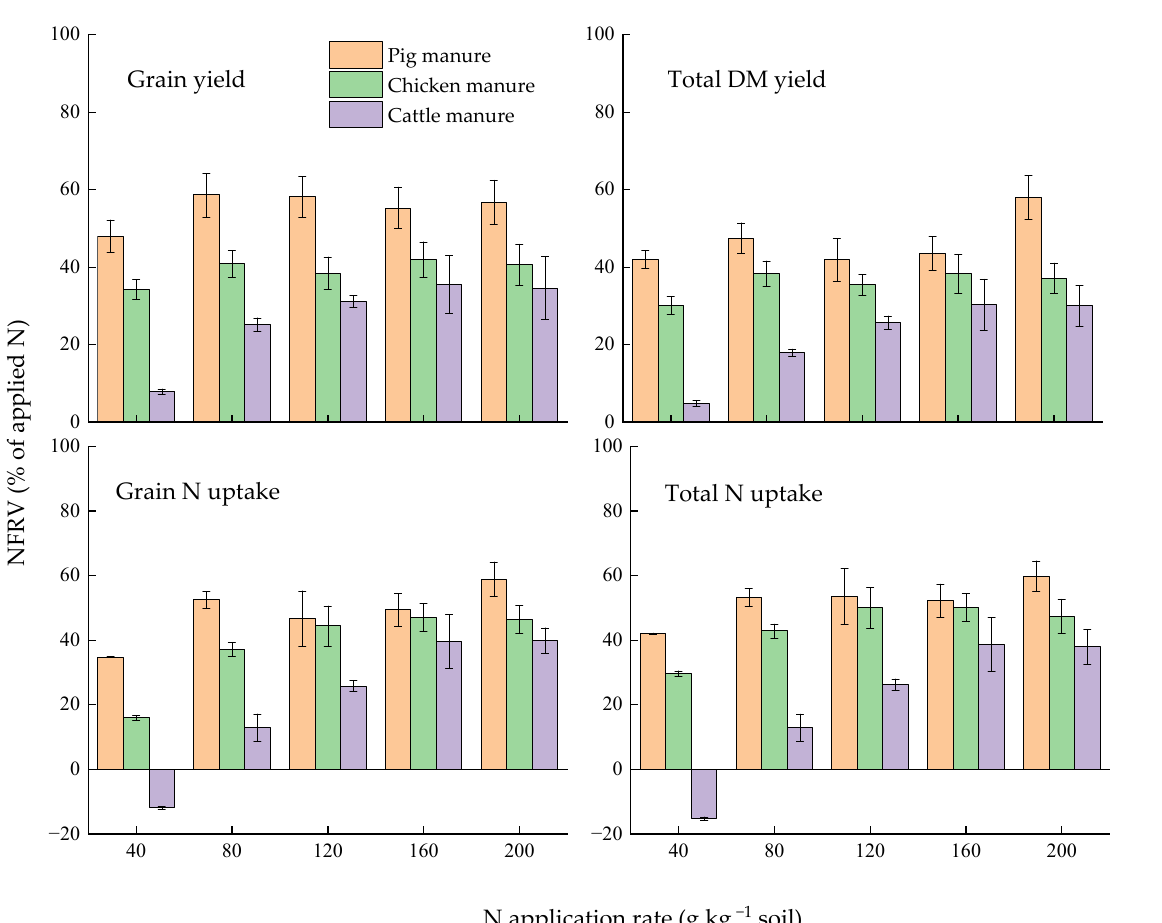
Figure 3. NFRVs of three representative livestock manures (% of total applied N) in summer maize. The NFRV was calculated based on the application rate-dependent regression coefficients of grain yield, total dry matter yield (Total DM), grain N uptake, and total N uptake. The error bars indicate standard errors ( n = 6).